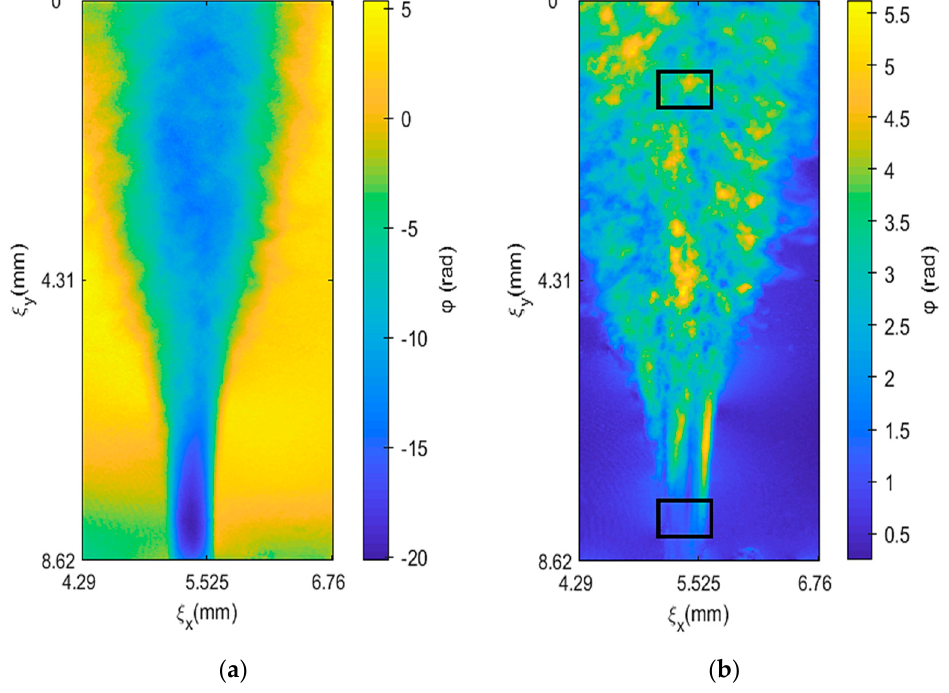
Figure 10. ( a ) Averaged phase map, ( b ) standard deviation.